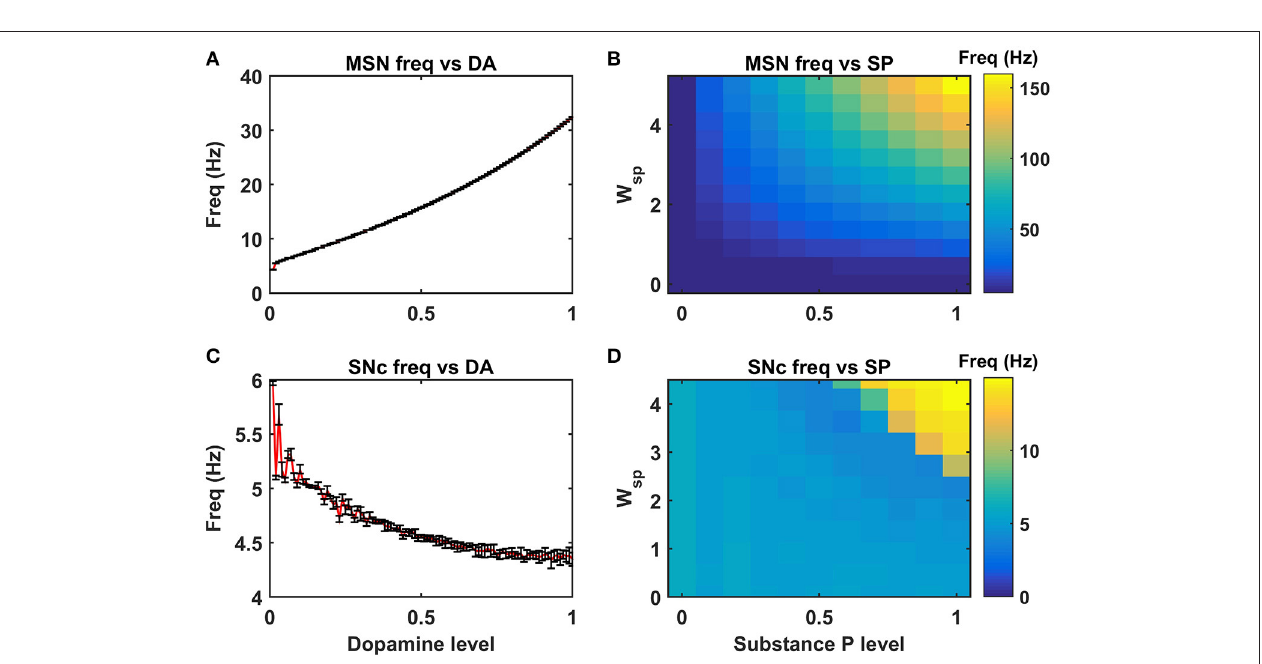
FIGURE 4 | Neuromodulatory effects of DA and SP on MSN and SNc neuronal populations. Effect of dopamine on MSN (A) and SNc (C) populations. Effect of SP on MSN (B) and SNc (D) . MSN, medium spiny neuron; DA, dopamine; Freq, frequency; SP, substance P; SNc, substantia nigra pars compacta; W sp , scaling factor of SP influence; Hz,